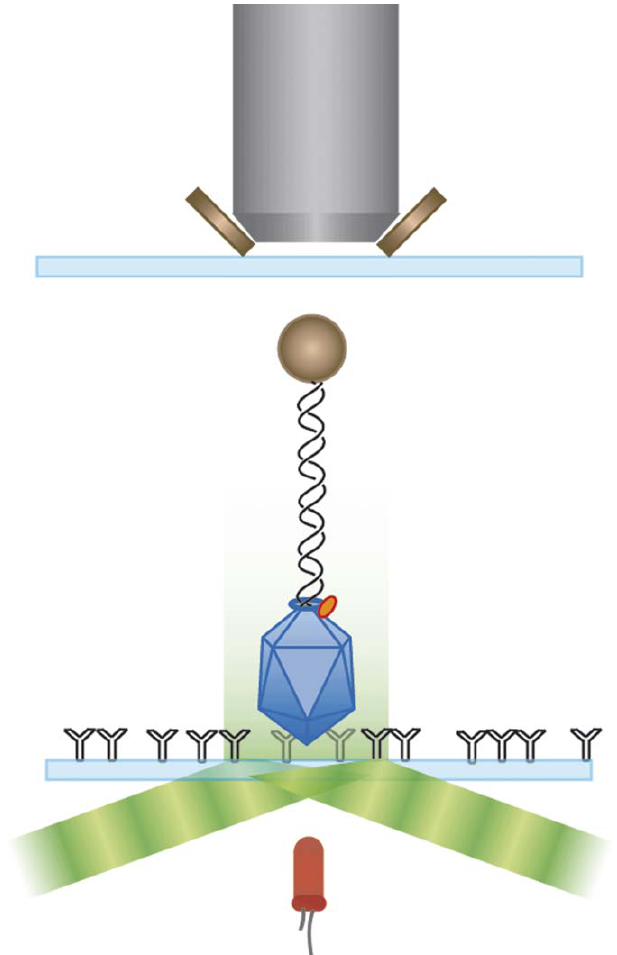
Figure 1. Schematic of the Experimental Geometry (Not to Scale) Stalled-packaging complexes are attached to the surface of the flow- chamber via biotinylated antibodies to the prohead major capsid protein, gp8. The dye molecule, attached to the connector, is excited via an evanescent wave using total internal reflection. The biotinylated free end of the DNA is attached to streptavidin-coated superparamagnetic beads that are pulled away from the fluorescence excitation by a magnetic field gradient that is created by a pair of magnets next to the objective. The magnetic beads are illuminated for video microscopy using a red LED; both the signals for bright-field and fluorescence images are collected by a high NA microscope